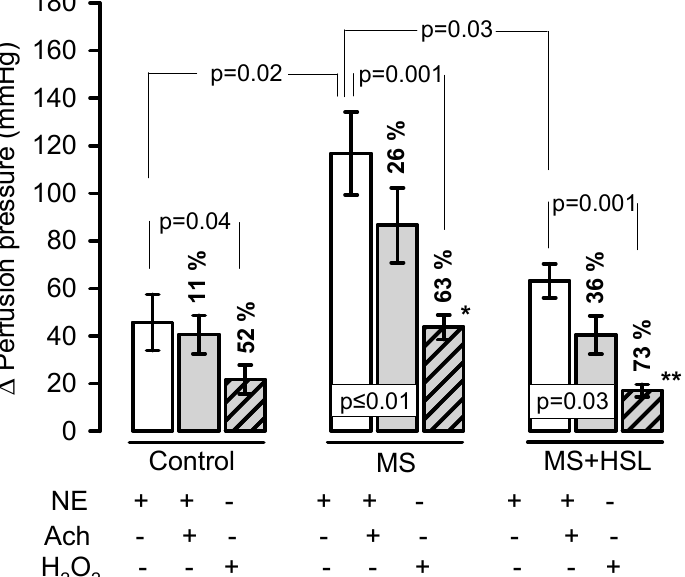
Figure 2. Changes the ∆ of the PP in the isolated kidney. The control, MS, and MS+HSL rats were perfused with NE 20 μ M, in presence of (Ach 20 μ M, and finally in presence of 1.7 μ M of H 2 O 2 . Data are expressed as changes the delta ( Δ ) of the PP in mmHg. After each perfusion bolus, the kidneys were washed for a period of 20 min with Krebs solution, to allow them to return to the basal PP (75–90 mmHg). Statistically significant at * p = 0.01 control vs. MS and ** p = 0.001 MS+HSL vs. MS. Abbreviations: Ach = acetylcholine, NE = norepinephrine, MS = metabolic syndrome, MS+HSL = metabolic syndrome plus Hibiscus sabdariffa L , PP = pressure perfusion. Data are expressed in means ± SE, (n = 8, rats in each group). Statistical significance was determined by one-way ANOVA test, followed by Tukey’s post hoc test.